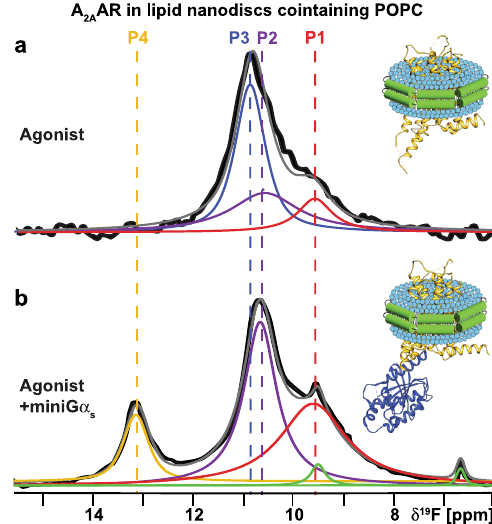
Fig. 2 | NMR-observedconformation ofanA 2A AR-agonist complex and ternary complex in nanodiscs containing only zwitterionic lipids. a A 1-dimensional 19 F-NMR spectrum of an A 2A AR[A289C TET ] complex with the agonist NECA in lipid nanodiscs containing the zwitterionic lipid POPC. b The 1-dimensional 19 F-NMR spectrum of an A 2A AR ternary complex with the agonist NECA and an engineered G α S protein in lipid nanodiscs containing POPC. Other fi gure presentation details the same as in Fig. 1, a and